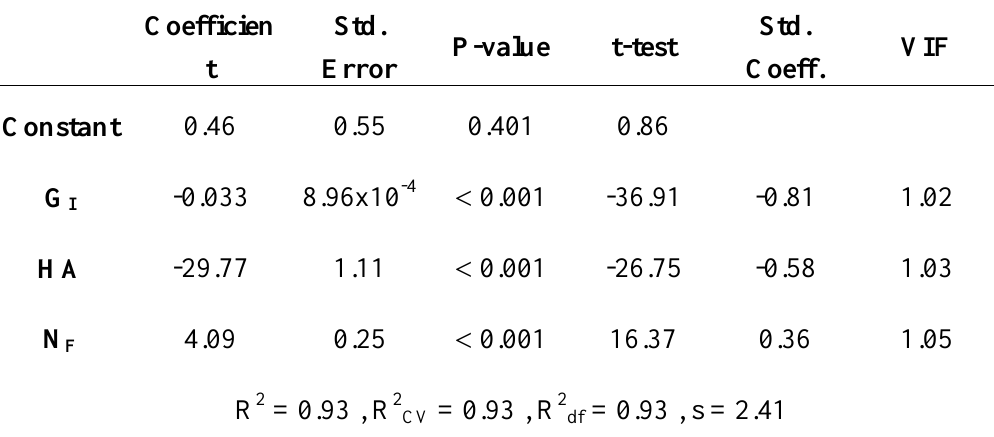
Table 1. Statistical parameters for the best QSPR model.